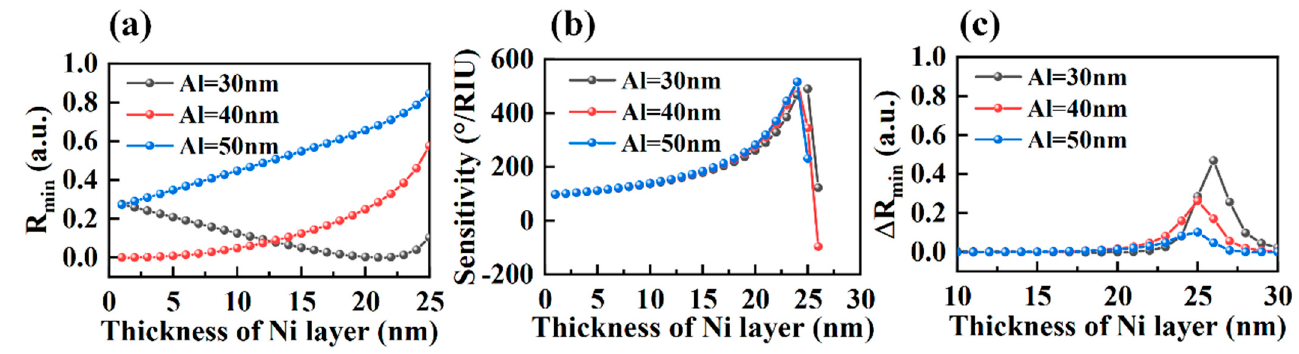
Figure 3. ( a ) The minimum reflectance of the bimetallic layer SPR sensor with various thicknesses of Al thin film (i.e., 30 nm, 40 nm, 50 nm) as a function of Ni thickness. ( b ) The sensitivity for different thicknesses of Al thin film (30 nm, 40 nm, 50 nm) at a fixed refractive index change in ∆ n = 0.005. ( c ) The difference of the minimum reflectance under the refractive indices of 1.335 and